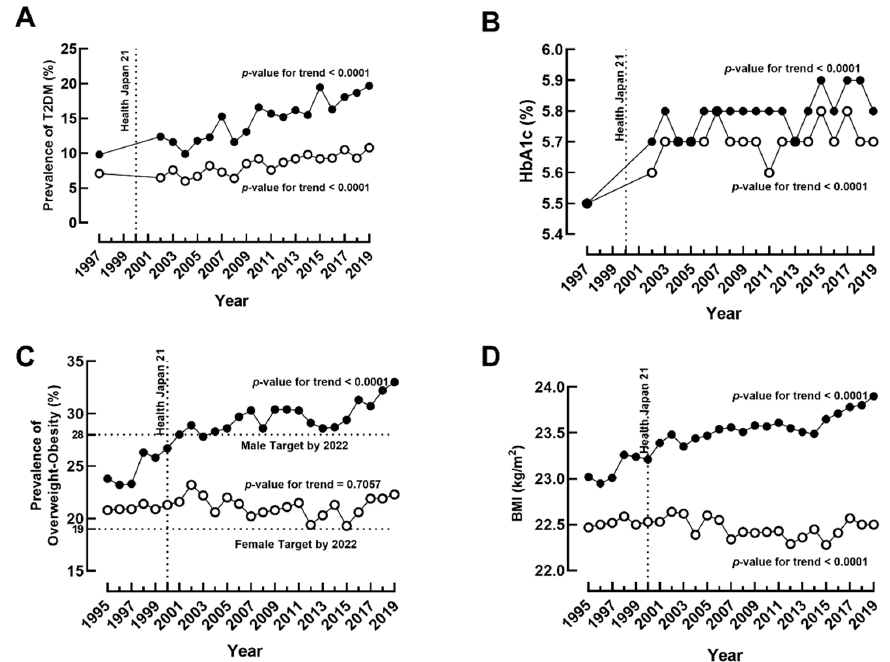
Figure 1. The prevalence of metabolic diseases and their predictors: ( A ) the prevalence of type 2 diabetes mellitus (T2DM) from 1997 to 2019, ( B ) the average annual glycated hemoglobin (HbA1c) from 1997 to 2019, ( C ) the prevalence of overweight/obesity from 1995 to 2019, and ( D ) the average annual body mass index (BMI) from 1995 to 2019 among males ( ● ) and females ( ○ ).